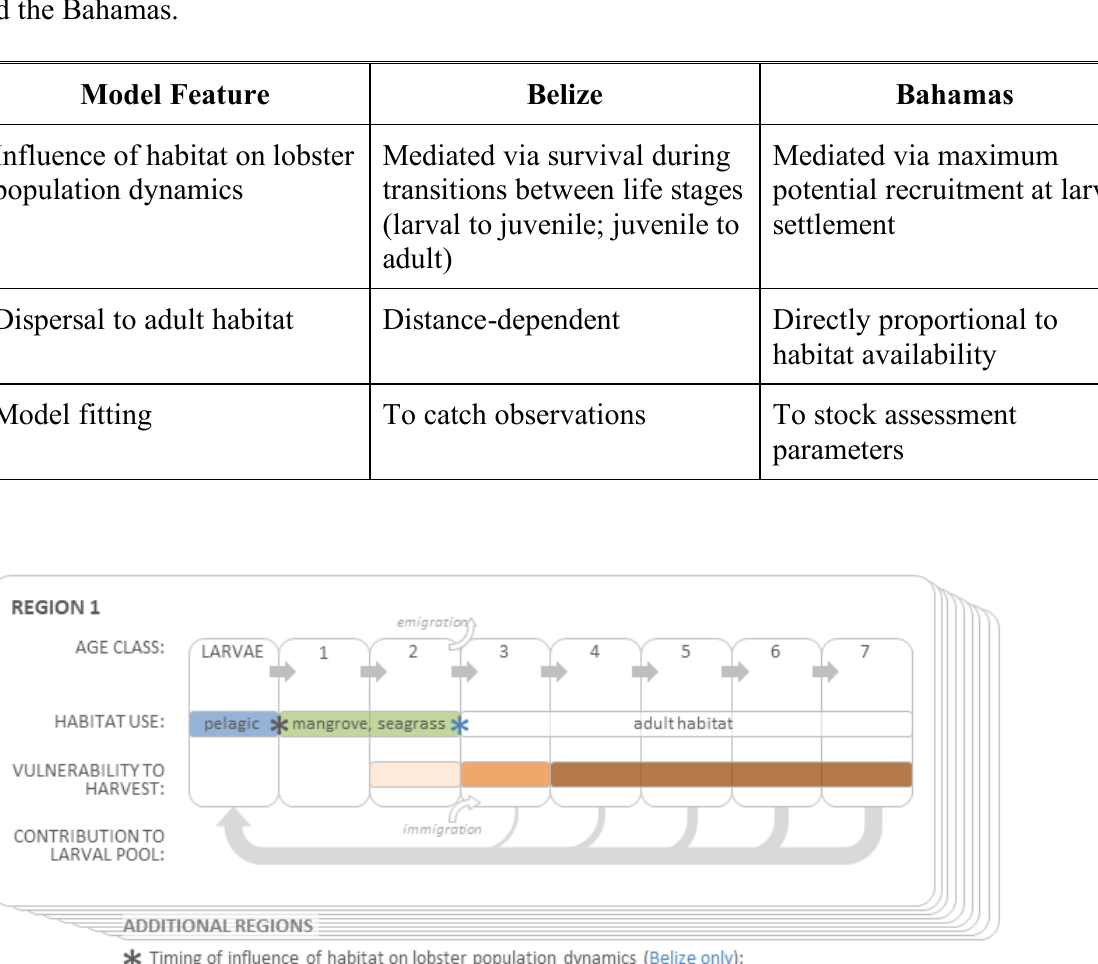
Figure A1.2 Conceptual diagram of lobster model where the asterisks indicate where habitat transitions occur that affect the lobster dynamics, either via recruitment (The Bahamas; gray asterisk) or mortality (Belize, gray and blue